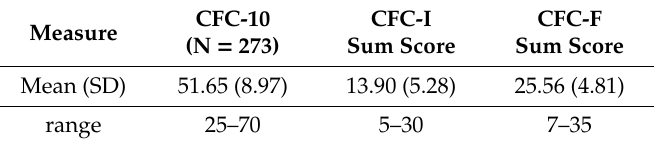
Table 5. Descriptive statistics of the CFC-10 sum score of CFC-F and inverted CFC-I items and its proposed subscales CFC-immediate and CFC-future for the whole sample of N = 273 participants.